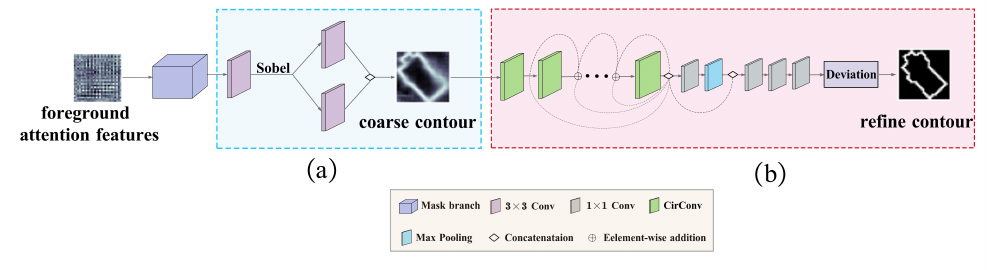
Figure 4. Structure of coarse-to-fine contour sub-network: ( a ) coarse contour branch, ( b ) refined contour